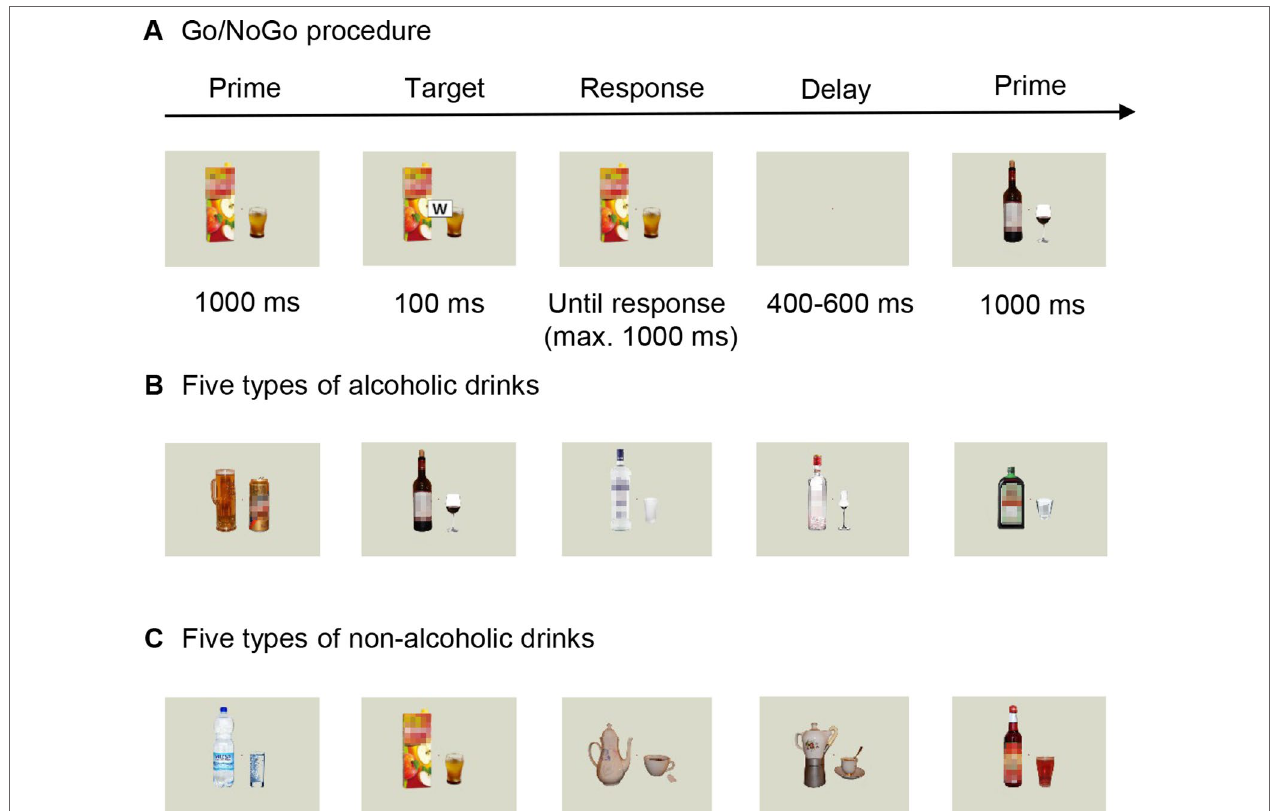
FIGURE 1 | Overview of our behavioral task. (A) Trial sequence in the Go/NoGo paradigm, with pictures of either (B) alcoholic drinks (beer, wine, vodka, fruit brandy, and liqueur) or (C) nonalcoholic beverages (mineral water, apple juice, tea, coffee, raspberry syrup) as prime stimuli. Please note that colored stimuli were used in both experiments. The blurred effect on the images was applied only in the